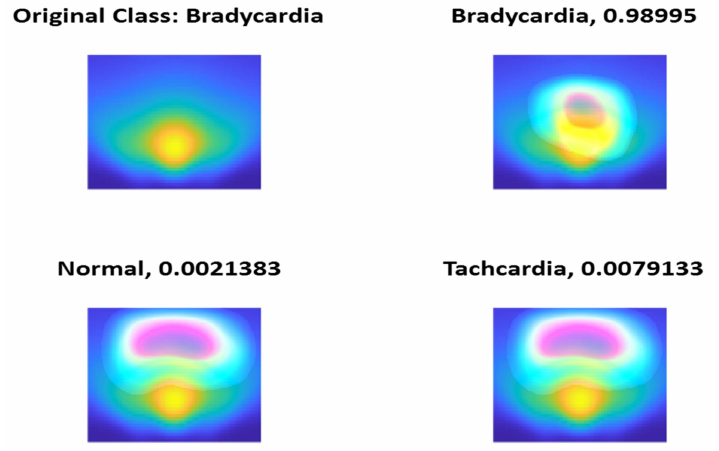
Figure 15. Bradycardia Class CAM using ShuffleNet and